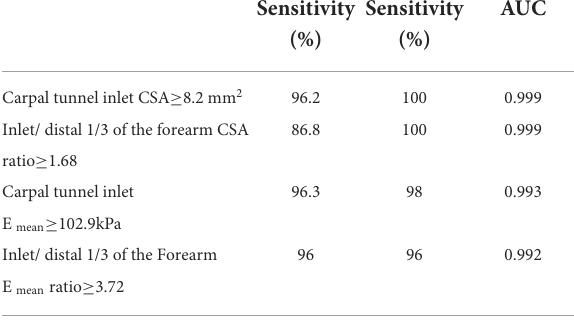
TABLE 3 Conventional ultrasound and shear wave elastography parameters of the preoperative group and the postoperative group.